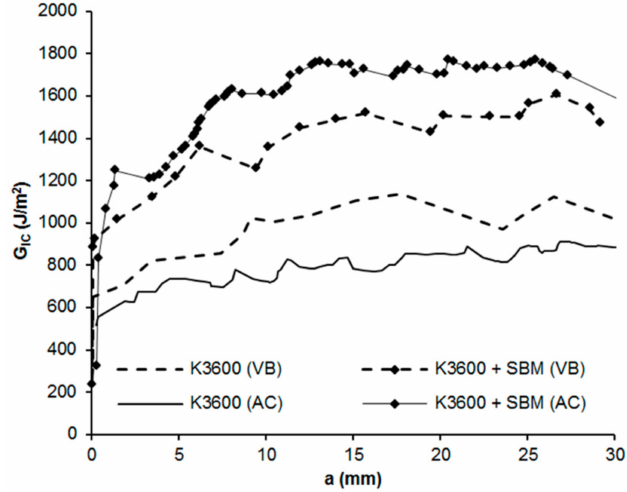
Figure 8. Representative delamination resistance curves (R-curves) for each of the coupon sets investigated. VAC: Vacuum bag cure method, AC: Autoclave cure